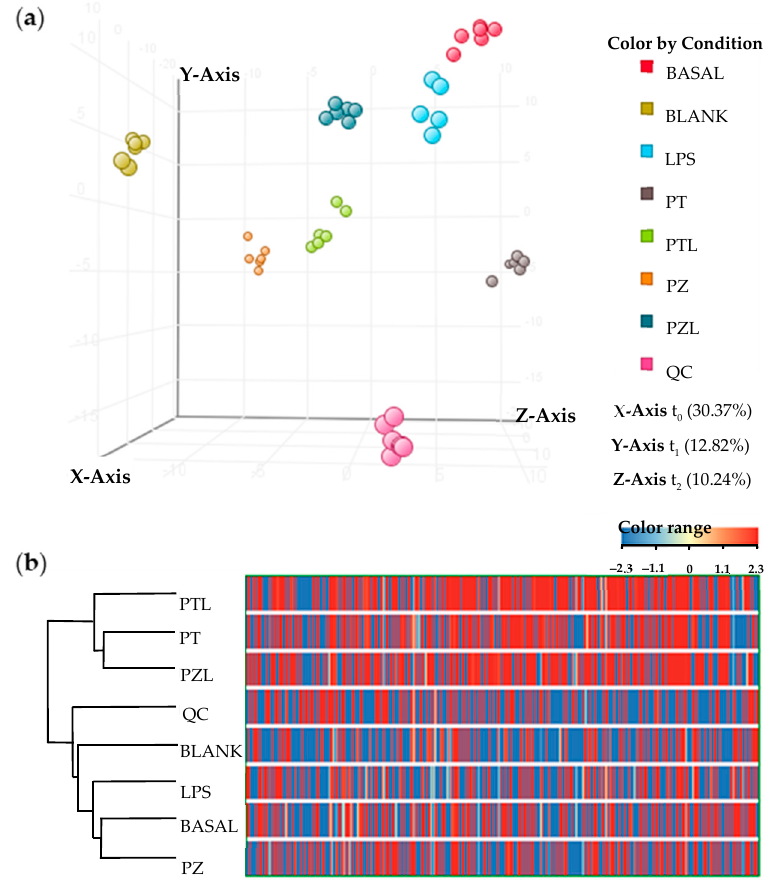
Figure 1. Multivariate statistical analysis of the subsequent evaluated conditions: Basal; LPS, lipopolysaccharide; PZ, phlorizin; PT, phloretin; PZL, phlorizin + LPS; PTL, phloretin + LPS; Blank and QC, quality control. ( a ) PLS-DA score plot (accuracy of the model of 91.254%, R 2 = 0.567 and Q 2 = 0.167); ( b ) Hierarchical clustering analysis by applying Pearson’s centered absolute similarity measure and complete linkage.